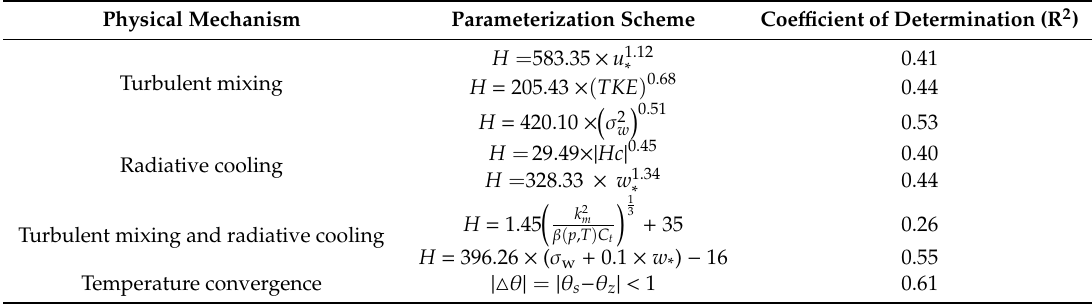
Table 2. All parameterization schemes developed in this study and corresponding coe ffi cients of